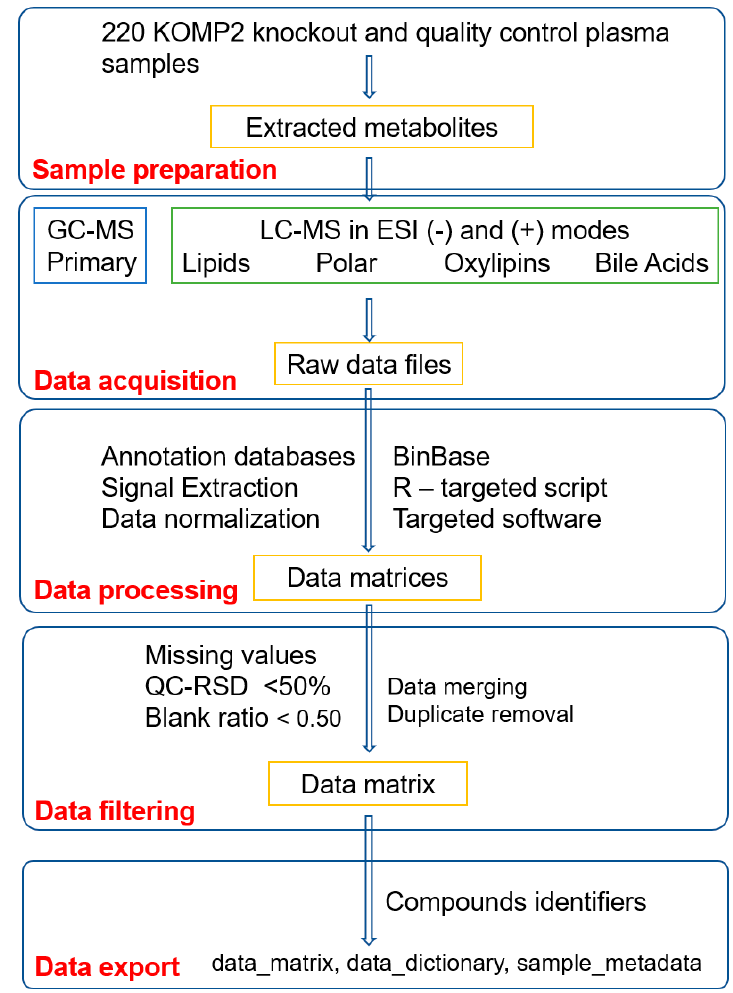
Figure 1. Overview of the metabolomics data generation and quality control workflow for 220 knockout mouse plasma (KOMP2) samples. A less stringent relative standard deviation (RSD) and sample to blank ratio were used because the effect size of two or more show a major effect. As raw spectra files are provided for this study, a user can re-generate the data matrix with different